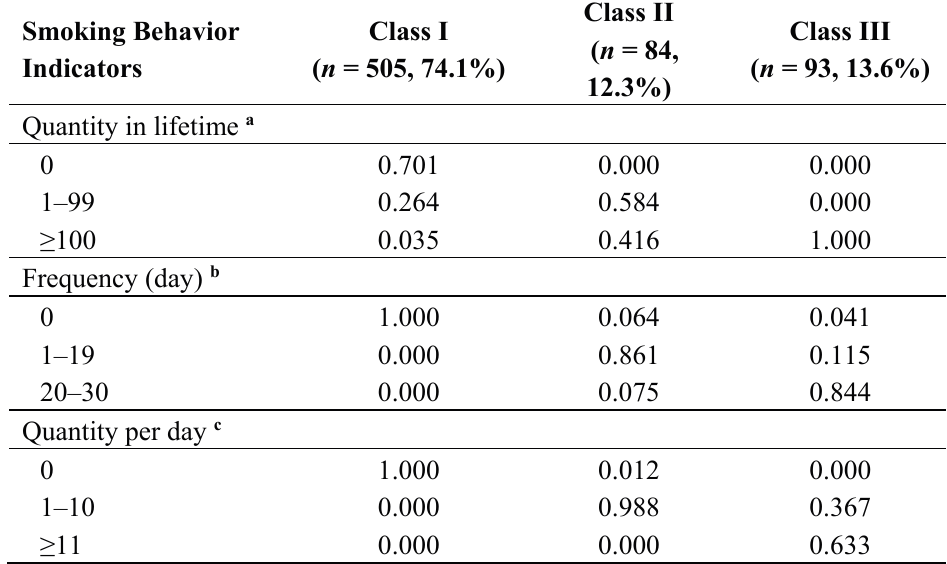
Table 2. Three-class item-response probabilities of smoking behavior